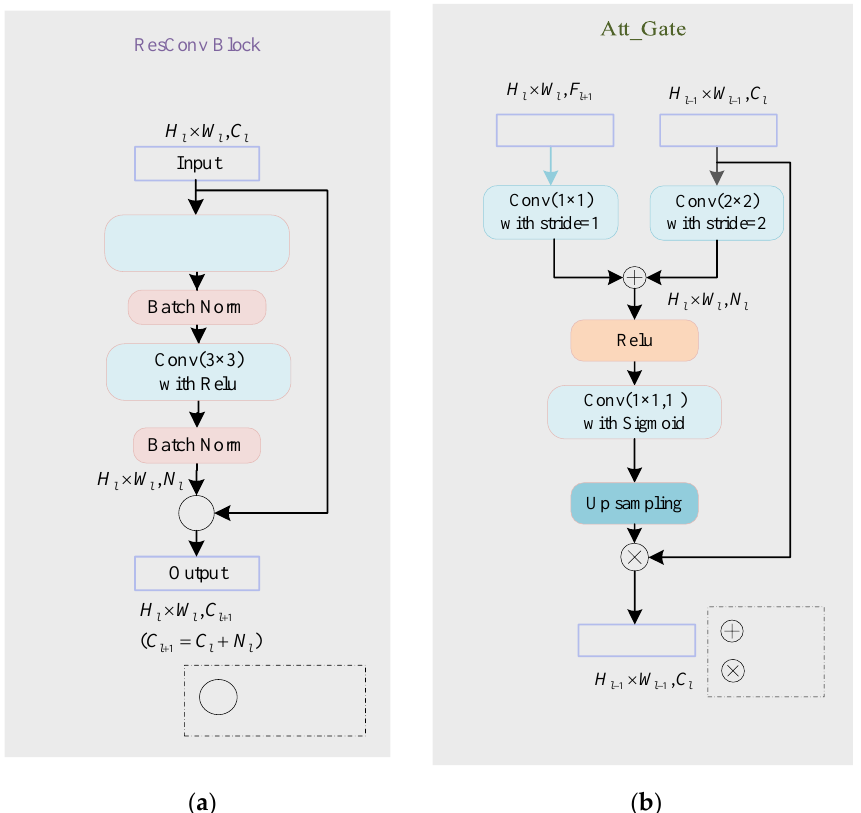
Figure 9. The detailed composition of ResConv Block and Att_Gate. ( a ) ResConv Block; ( b ) Att_Gate.